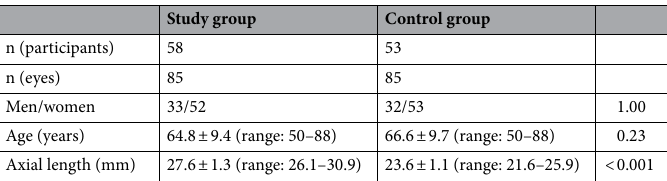
few large choroidal vessels were present in gamma zone (Fig. 2). Within the group of the 39 highly myopic eyes with a choroidal shift on the disc-fovea line, the choroidal shift in eyes without choroidal vessels in gamma zone as compared with eyes with large choroidal vessels in gamma zone was significantly more often similar to the gamma zone enlargement (19/22 (86%; 95% CI 71, 100); P = 0.002) versus 5/15 (33%; 95% CI 6.3, 60.4)), while it was in a significantly lower frequency smaller than the gamma zone enlargement (2/22 (9%; 95% CI 0, 22); P = 0.002) versus 9/15 (60%; 95% CI 32, 88)) (Figs. 1, 2). Within the group of the 39 highly myopic eyes with a choroidal shift in the disc-fovea line, 9 (23%) eyes showed a localized increase in the choroidal inter-vessel distance, 10 (26%) eyes showed a localized decrease in the choroidal inter-vessel distance, and one eye showed a mix of localized increase and localized decrease. In 14 (17%) eyes, a choroidal shift was observed in association with the development or enlargement of a diffuse chorioretinal atrophy or a macular BM defect (Figs. 1, 2, 3, 4, 5, 6). In 10 (71%) of these 14 eyes, there was an additional choroidal shift in the disc-fovea line. The BM defect-associated choroidal shift showed a centrifugal movement of the choroidal vessels away from the center of the BM defect in eyes with a mostly circular BM defect. In the case of an elongated BM defect, the shift of the choroidal vessels occurred in a direction perpen- dicular to the longest diameter of the lesion. In eyes with a macular BM defect with visible choroidal vessels at its ground, the inter-vessel distance in the choroidal large vessel layer did not markedly change (Fig. 7). In the non-highly myopic group, the choroidal vessel shift occurred on the disc-fovea line in 6 (7%) of the 85 non-highly myopic eyes. In 5 (83%) of the 6 eyes, the choroidal shift was similar to the enlargement in the width of gamma zone; in one (17%) eye, the choroidal shift was smaller than the gamma zone enlargement. Since BM defects did not occur in the non-highly myopic eyes, there were no choroidal changes in association with BM defects in the non-highly myopic group.